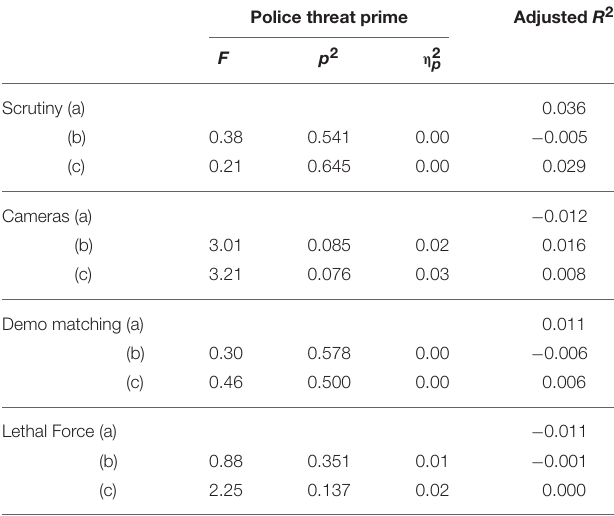
TABLE 4 | Results of Study 2 multivariate analysis of variance using manipulated threat associated with police officers to predict support for policing policy reform